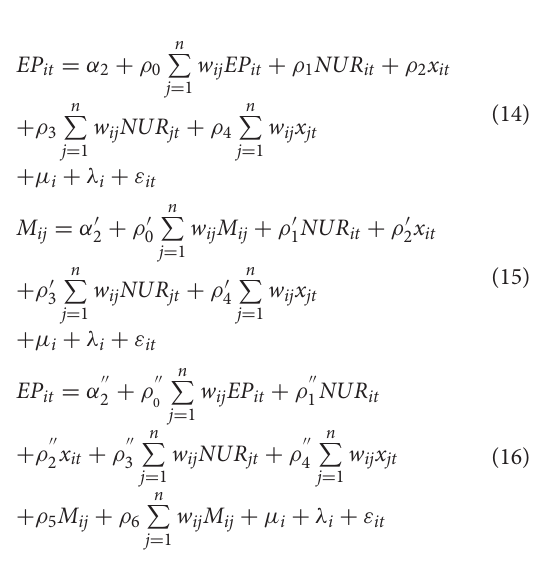
Frontiers in Public Health |